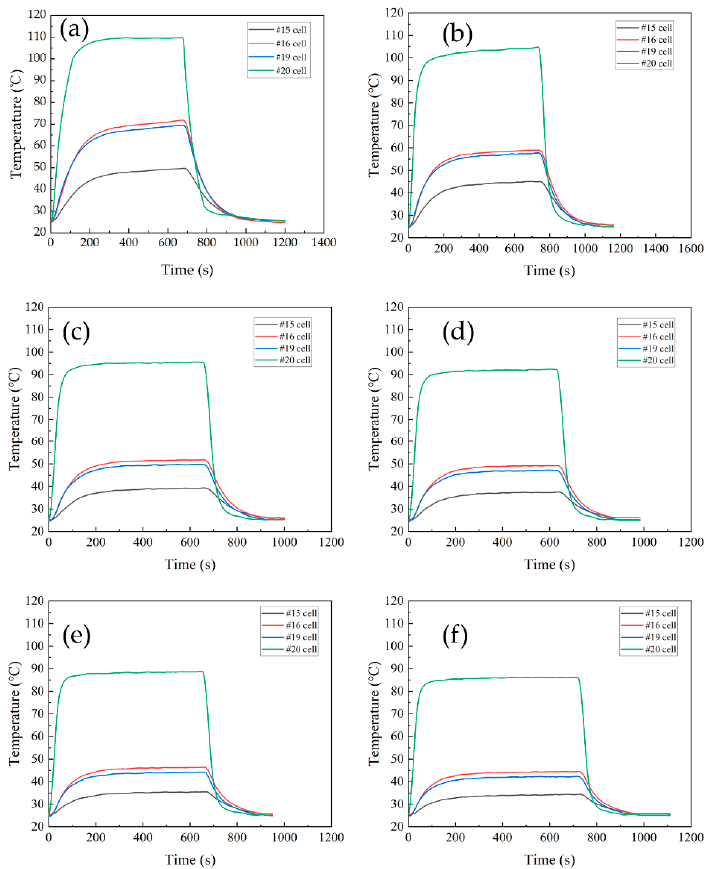
Figure 12. The change in battery module temperature with time at different flow speeds. ( a ) 0.4 m/s,